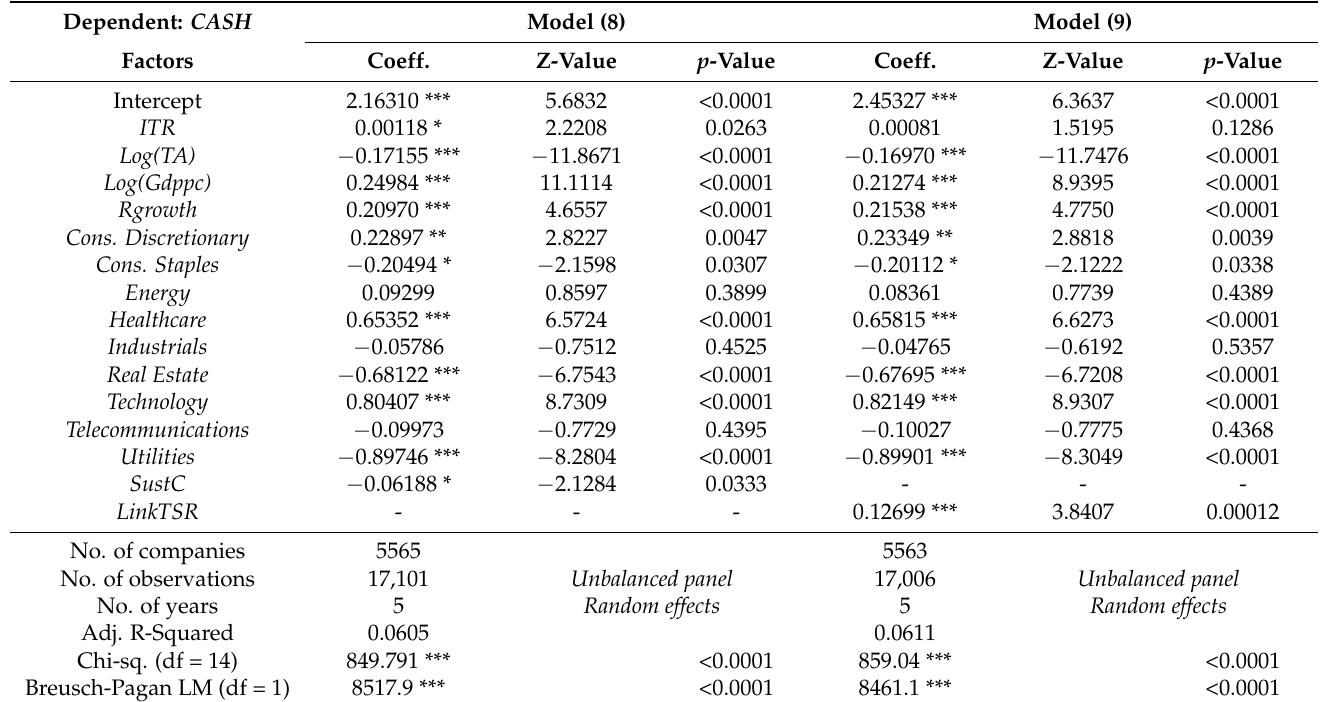
Table 11. Panel regression results for the natural logarithm of the cash ratio ( CASH ) as the dependent